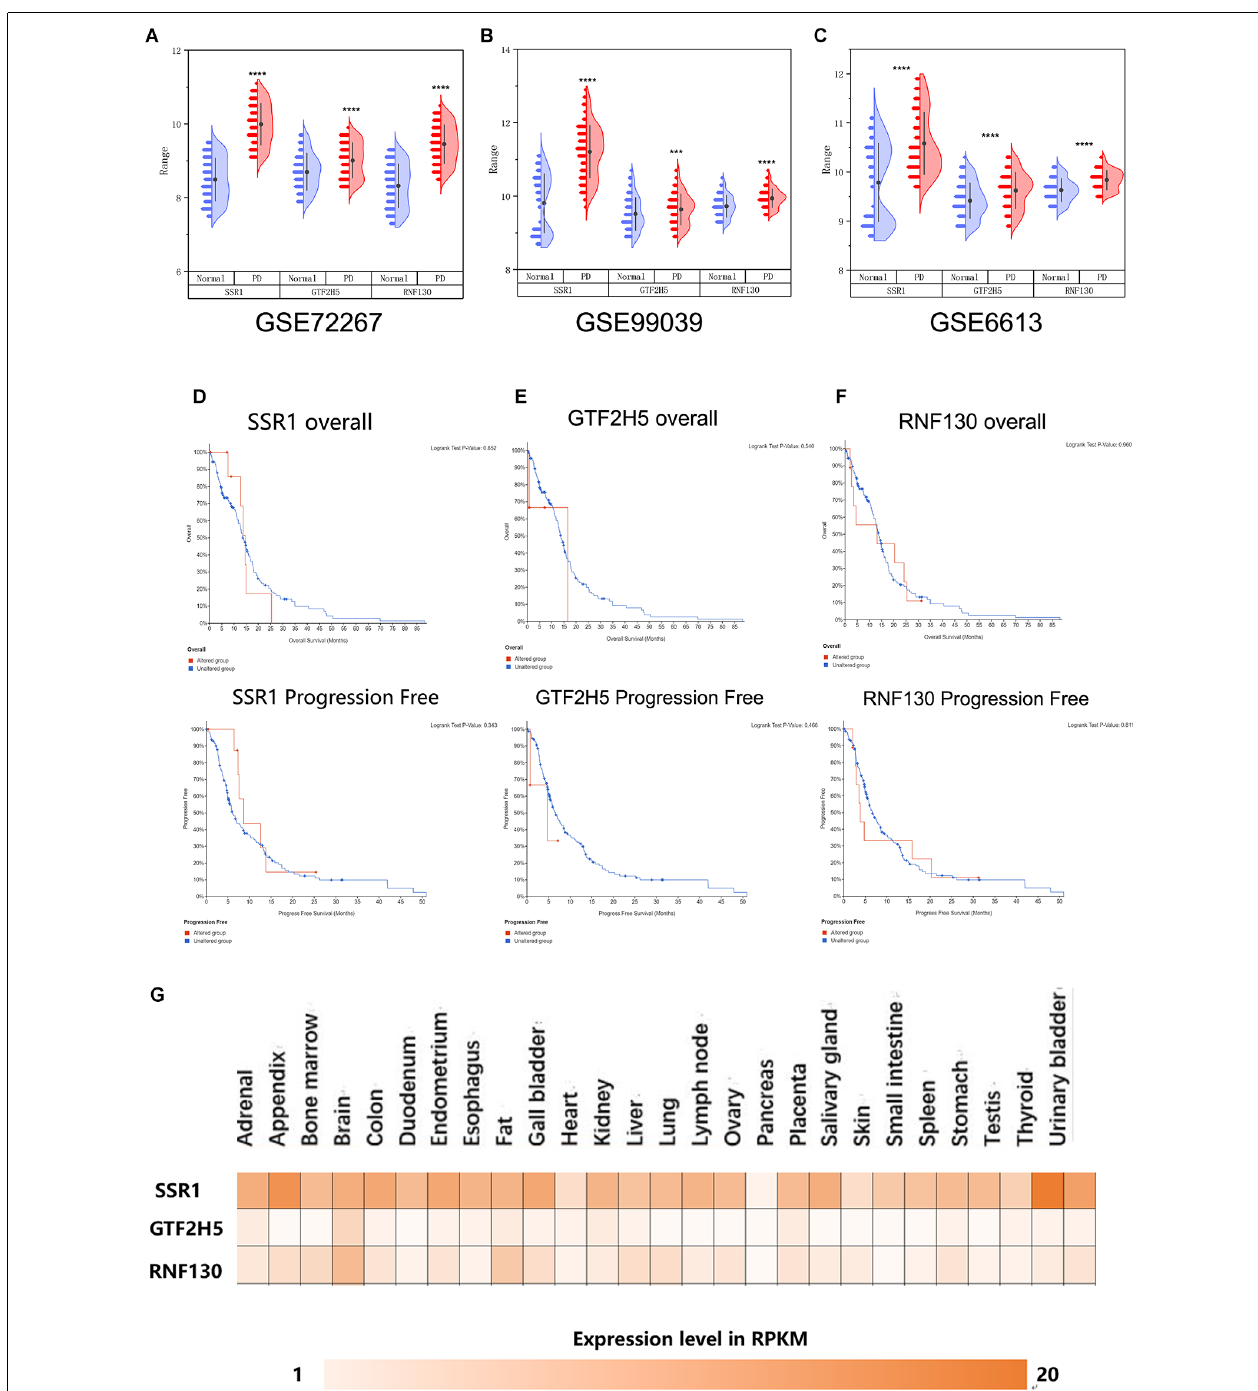
FIGURE 5 | Analysis of the correlation between three hub genes and PD based on bioinfarmatics. (A–C) Verification of hub genes based on peripheral blood datasets: GSE72267, GSE99039, and GSE6613. (D–F) Overall survival and disease-free survival analyses of three hub genes were performed using cBioPortal online platform. P < 0.05 was considered statistically significant. (G) Expression level of three hub genes in